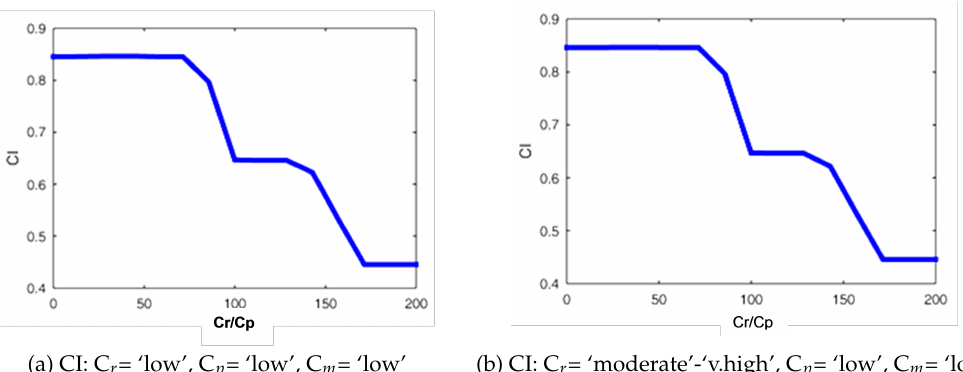
Fig. 6. Effect of costs interaction on varying cost implication decisions (type 1)